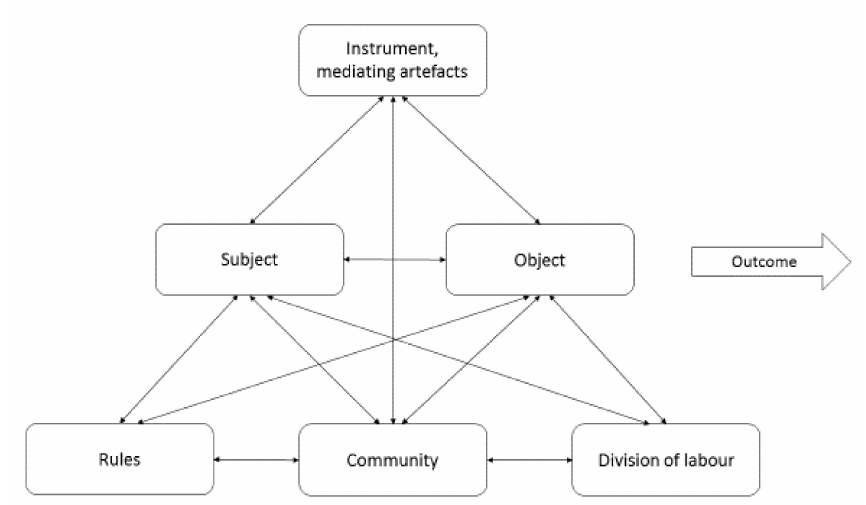
Figure 2. The activity system model (ASM)—Engeström’s triangle (modified from [117] (p.